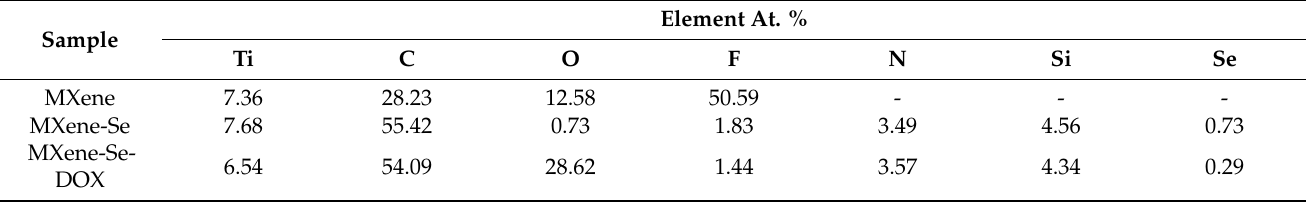
Table 1. Atomic concentrations of elements on the surfaces of MXene, MXene-Se, and MXene-Se-DOX